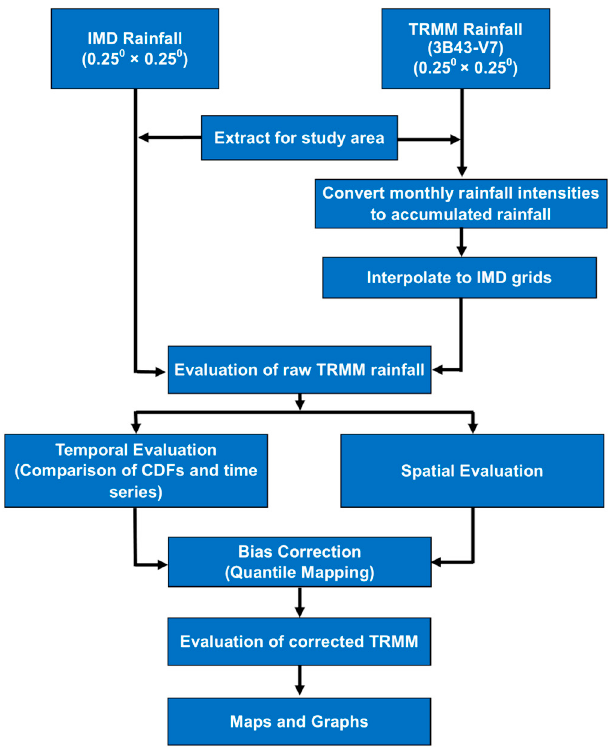
Figure 2. Flow chart of the methodology. Table 1. Details of the datasets used in this study.